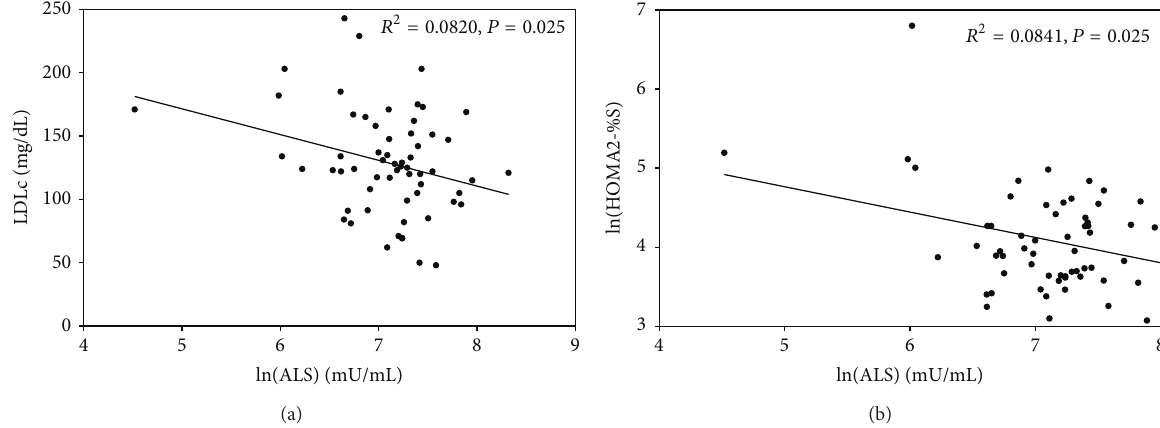
Figure 2: Relationships between acid-labile subunit (ALS) levels and metabolic parameters. The correlations of ALS levels with low-density lipoprotein cholesterol (LDLc) concentrations (a) and homeostatic model assessment version 2 insulin sensitivity (HOMA2-%S) (b) were significant at